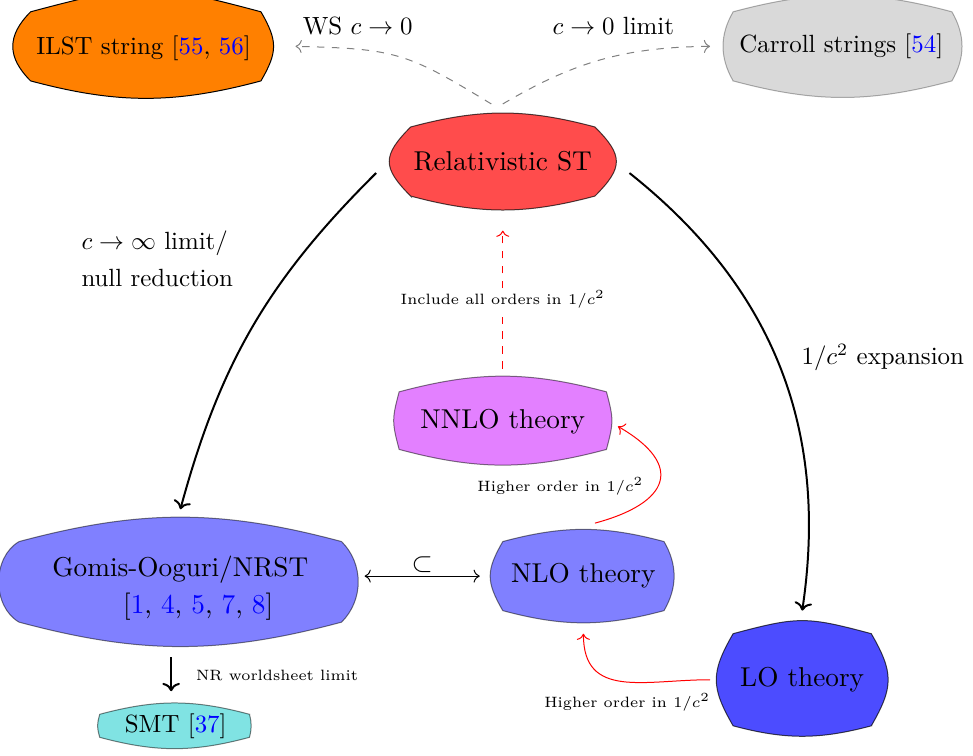
Figure 1 . Relations between relativistic string theory and various non-Lorentzian avatars. Starting from relativistic string theory, taking a string c → ∞ limit or performing a null reduction leads to the Gomis-Ooguri string [1, 2, 4], which is contained in the NLO theory we get from a string 1 /c 2 expansion [5, 7, 8]. Taking a worldsheet NR limit of the Gomis-Ooguri string leads to spin matrix theory (SMT) strings [5, 8, 10, 37] (see also [57]). If we instead take a Carrollian worldsheet limit of relativistic string theory where the worldsheet speed of light goes to zero, we get the ILST (or tensionless) string [55, 56]. This is classically equivalent to the ambitwistor string [58, 59]. We also note that one may instead take an ultralocal limit in target space, where the speed of light goes to zero. This was considered in a phase space formulation in